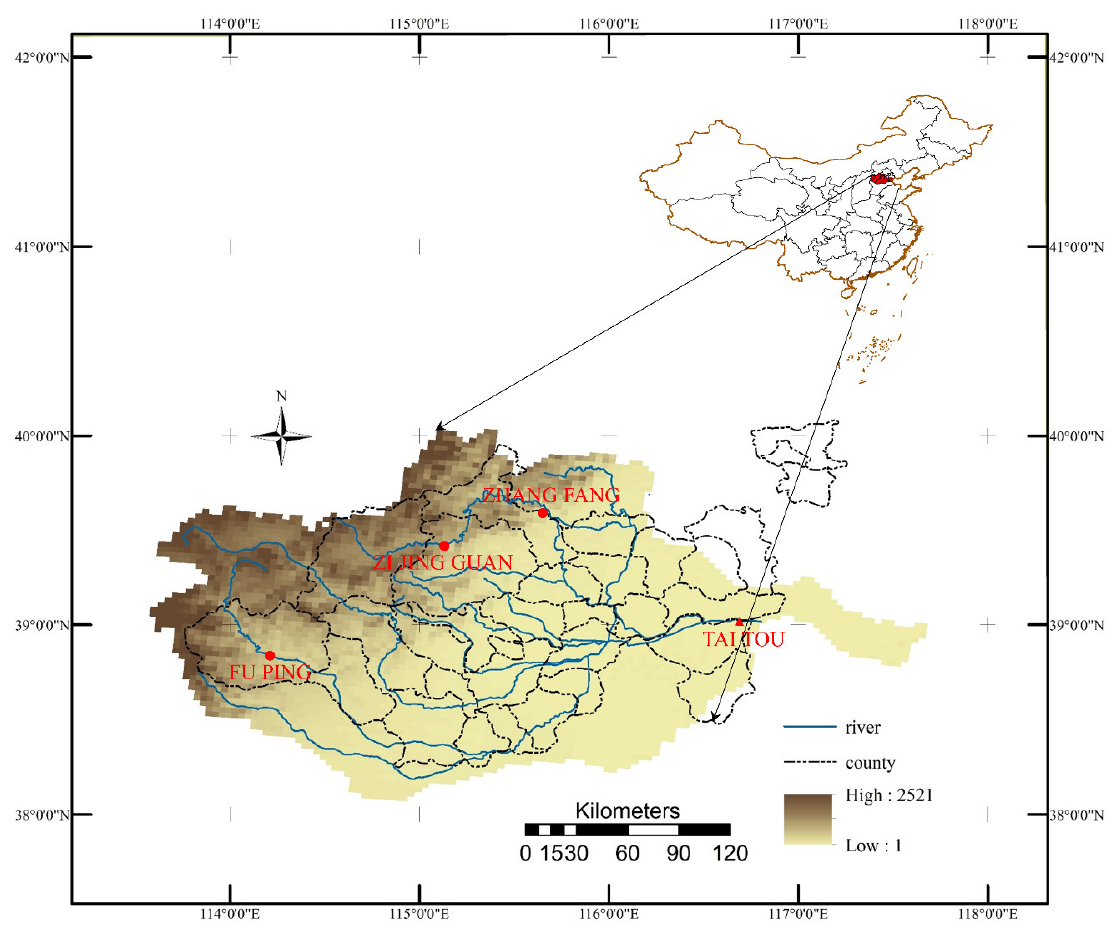
Figure 1. Schematic diagram of the location of the Daqing River Basin .